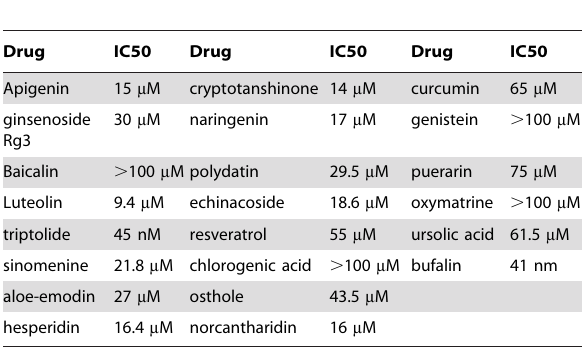
Table 3. Half inhibition concentration (IC50) of candidate drugs for LoVo